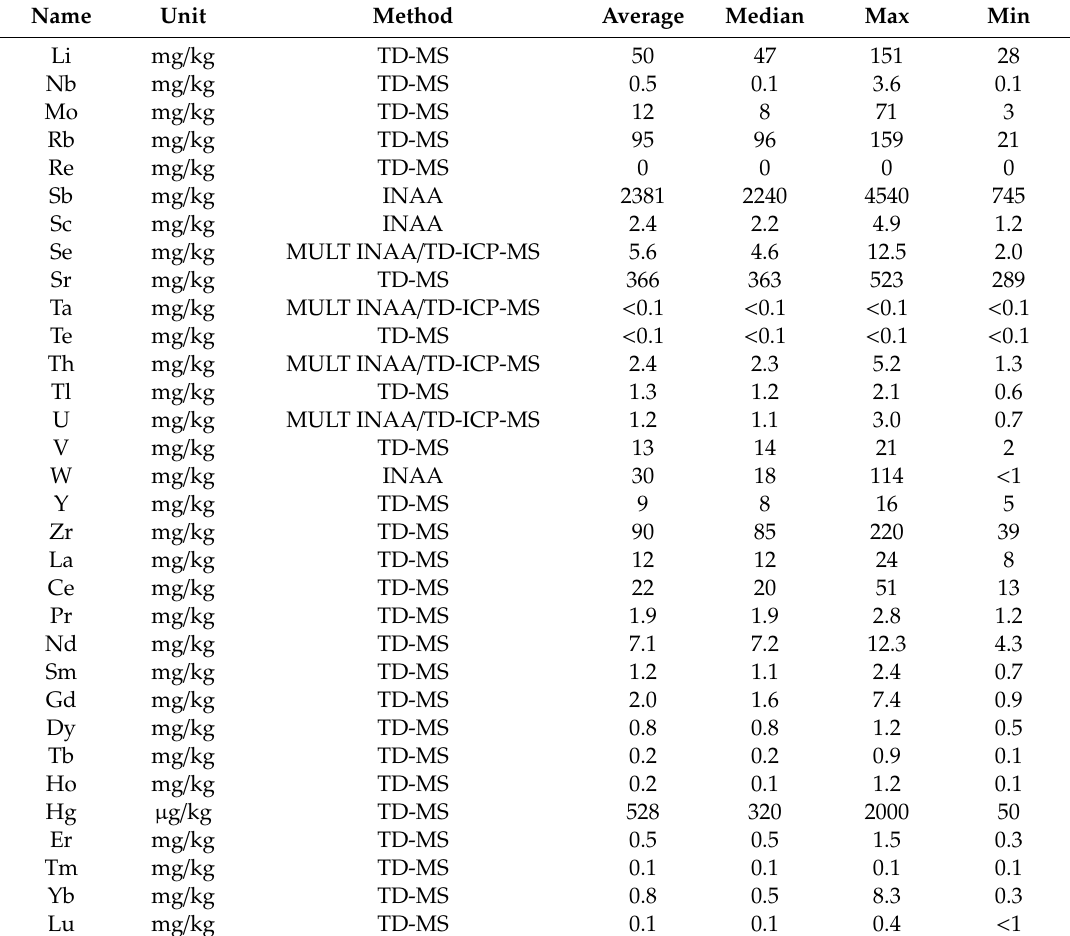
Table A2. Measured elements in Swiss